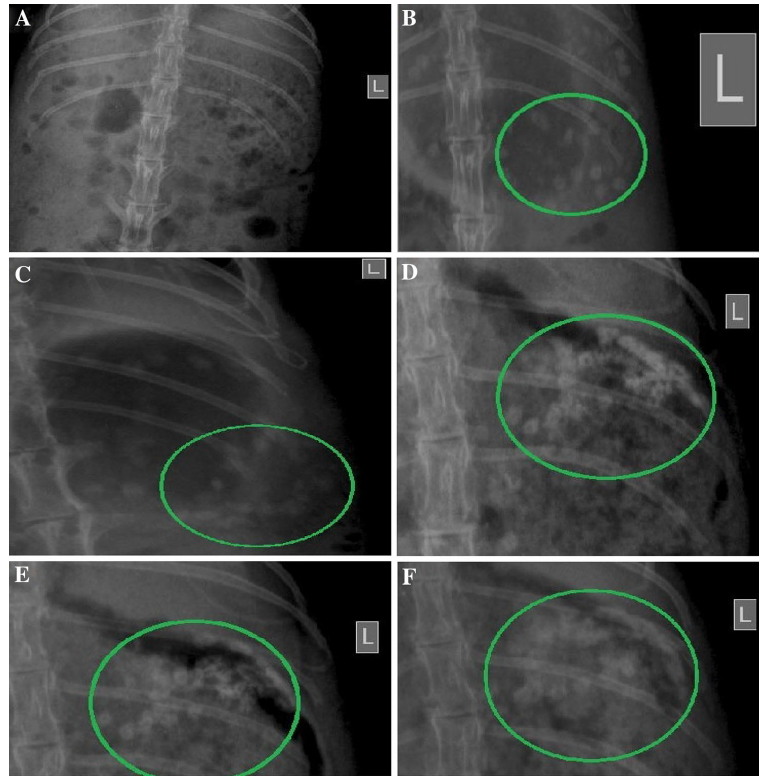
Figure 16. Radiographic images taken on the rabbit during radiological studies [gastric retention of pectin-xanthan gum-locust bean gum hollow/porous floating beads as pulsatile drug delivery system] at predetermined time intervals ( A – F ). The presence of the beads was marked with the green circles. Reproduced from [137] with permission.